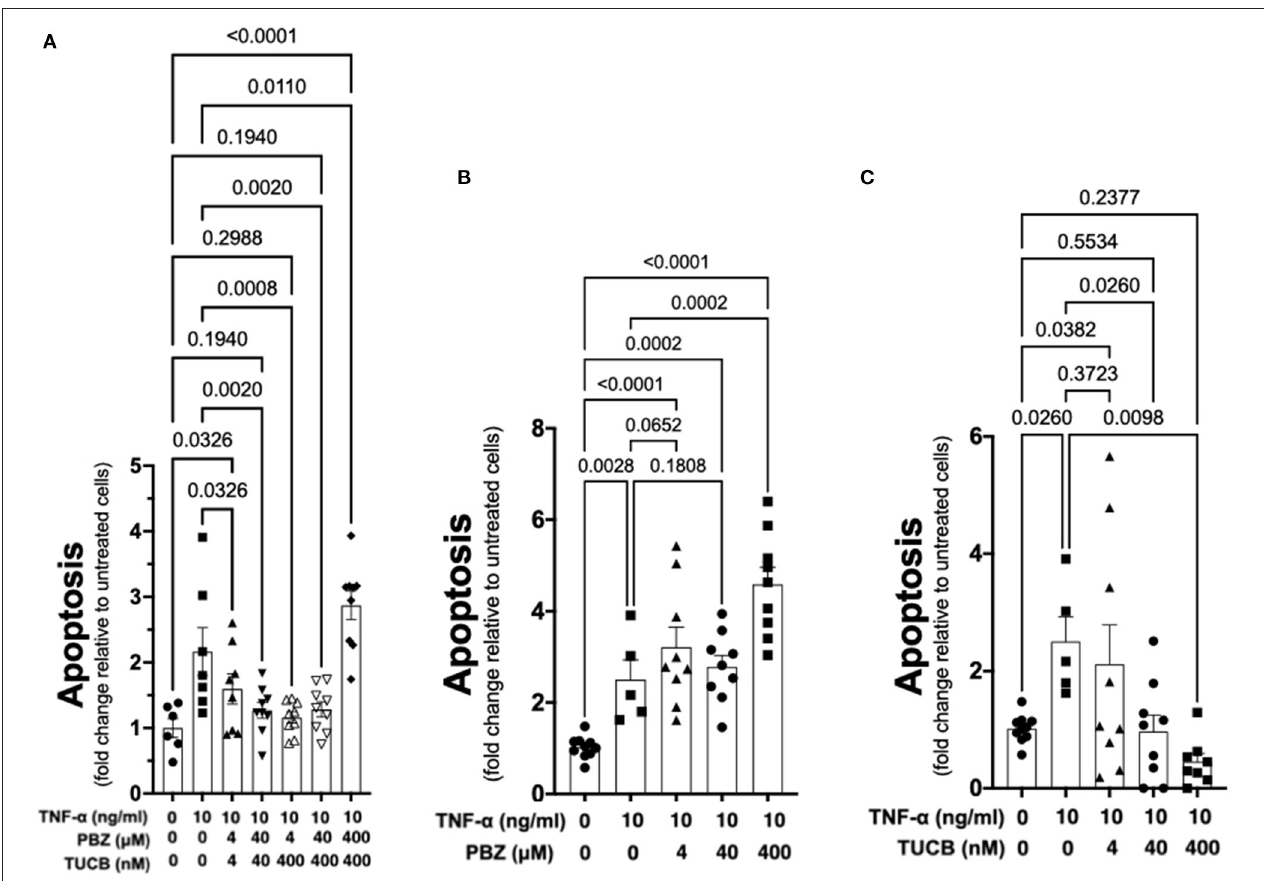
FIGURE 6 | Soluble epoxide hydrolase (sEH) inhibition prevents cytokine-induced chondrocyte apoptosis. Primary equine articular chondrocytes were incubated with TNF- α (10ng/ml) for 24h along with several concentrations of the cyclooxygenase (COX) inhibitor phenylbutazone (PBZ) combined with the sEH inhibitor trans -4-{4-[3-(4-Trifluoro- methoxy-phenyl)-ureido]-cyclohexyloxy}-benzoic acid (TUCB) (A) , with PBZ alone (B) or with TUCB alone (C) . PBZ and TUCB were used at their approximate half-maximal inhibitory concentration or IC 50 (4), IC 80 (40), and 10-fold > IC 80 (400) for the equine enzymes. Negative controls were treated with 0.9% saline (vehicle diluent for TNF- α ) or ethanol (vehicle diluent for PBZ and TUCB; 0.0001% final concentration in culture medium). Apoptosis was determined using ELISA technique as per the manufacturer’s instructions. Concentrations are listed below each graph. Data are shown as individual values (symbols) and mean ± SEM (columns), and p -values are shown above each comparison (One-way ANOVA corrected for multiple comparisons by controlling the False Discovery